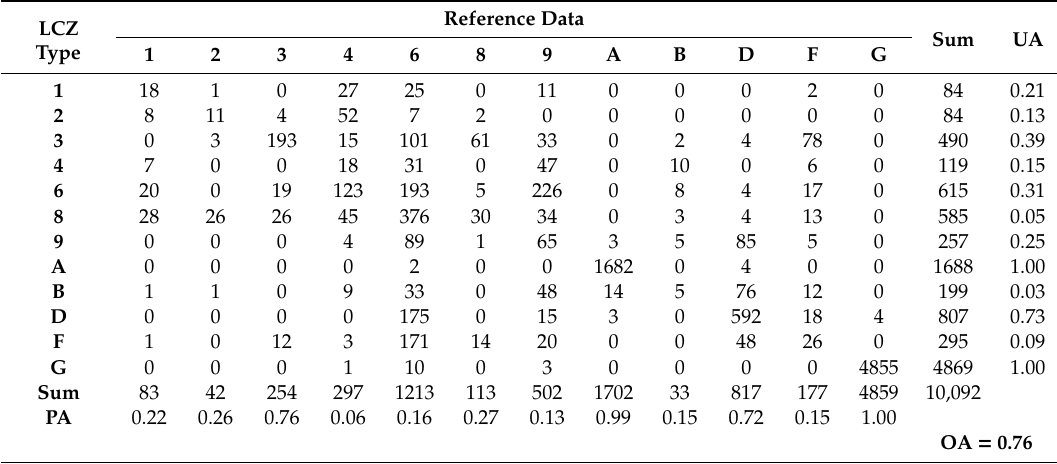
Table 2. Traditional error matrix generated using our synthetic dataset with 12 LCZ